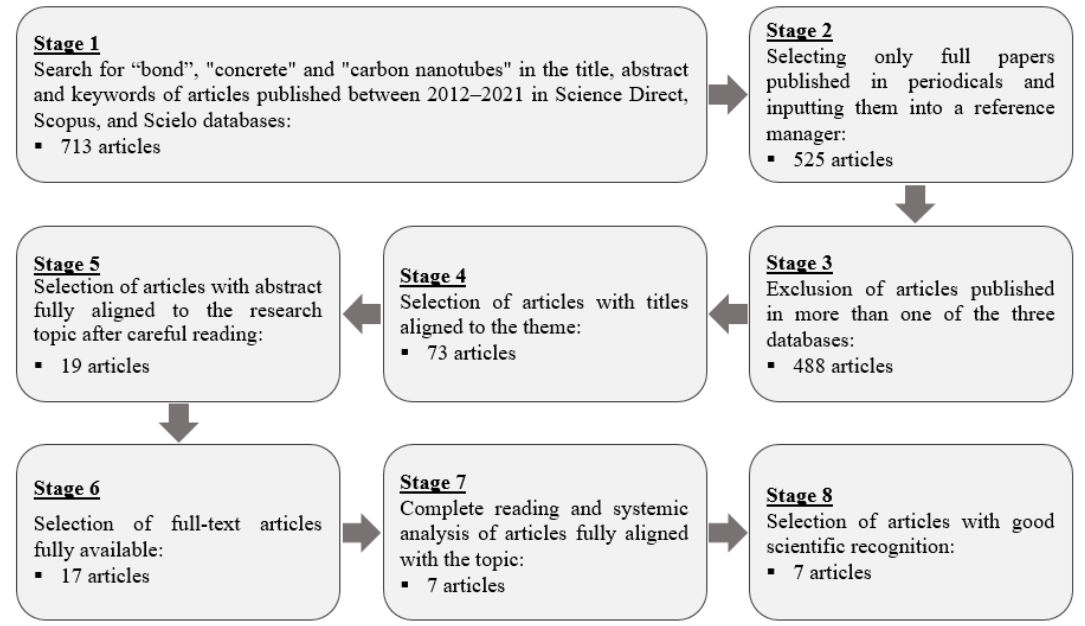
Figure 1. Stages of a systematic review of the literature using ProKnow-C.